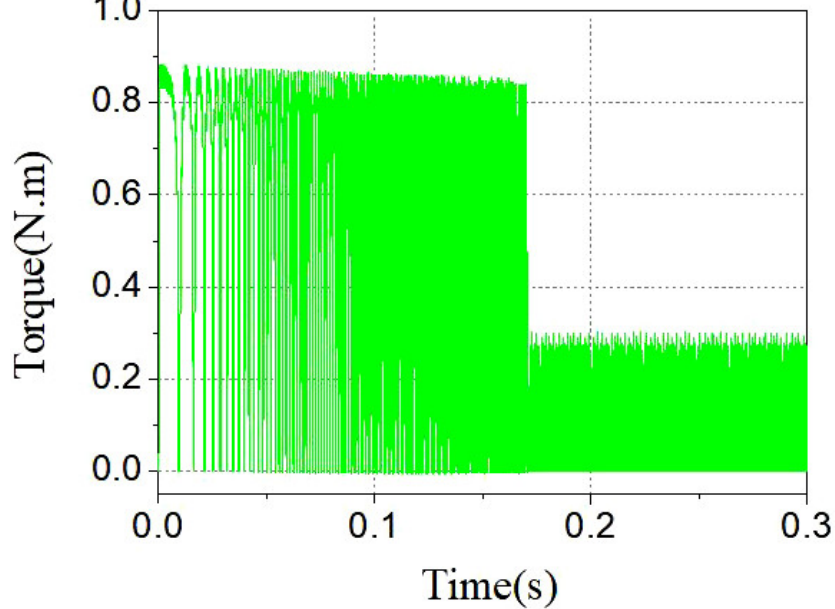
Figure 20. Torque variation during the speed regulation process.